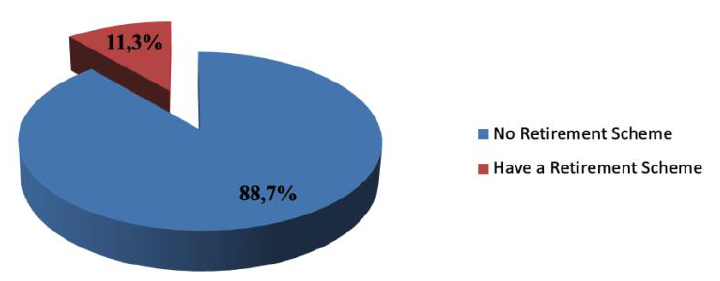
Figure 2: Distribution of Respondents by Membership of Retirement